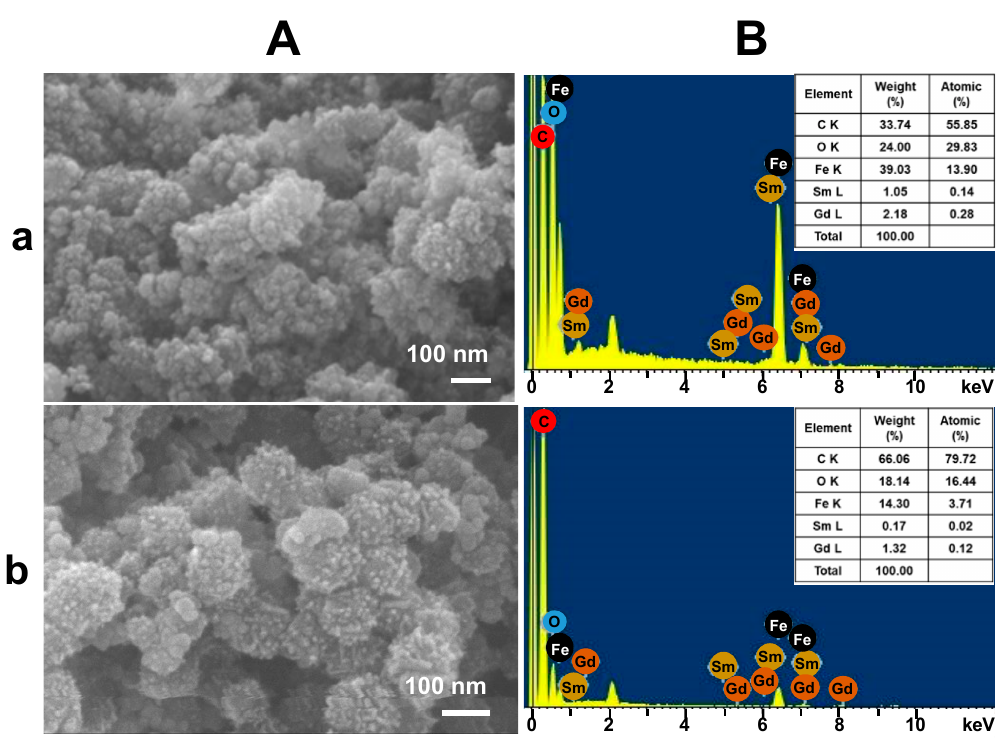
Figure 3. ( A ) SEM images and ( B ) EDX of ( a ) CNH/Fe 3 O 4 /Sm 2 O 3 /Gd 2 O 3 and ( b ) CNH/Fe 3 O 4 @Cdot/Sm 2 O 3 /Gd 2 O 3 .